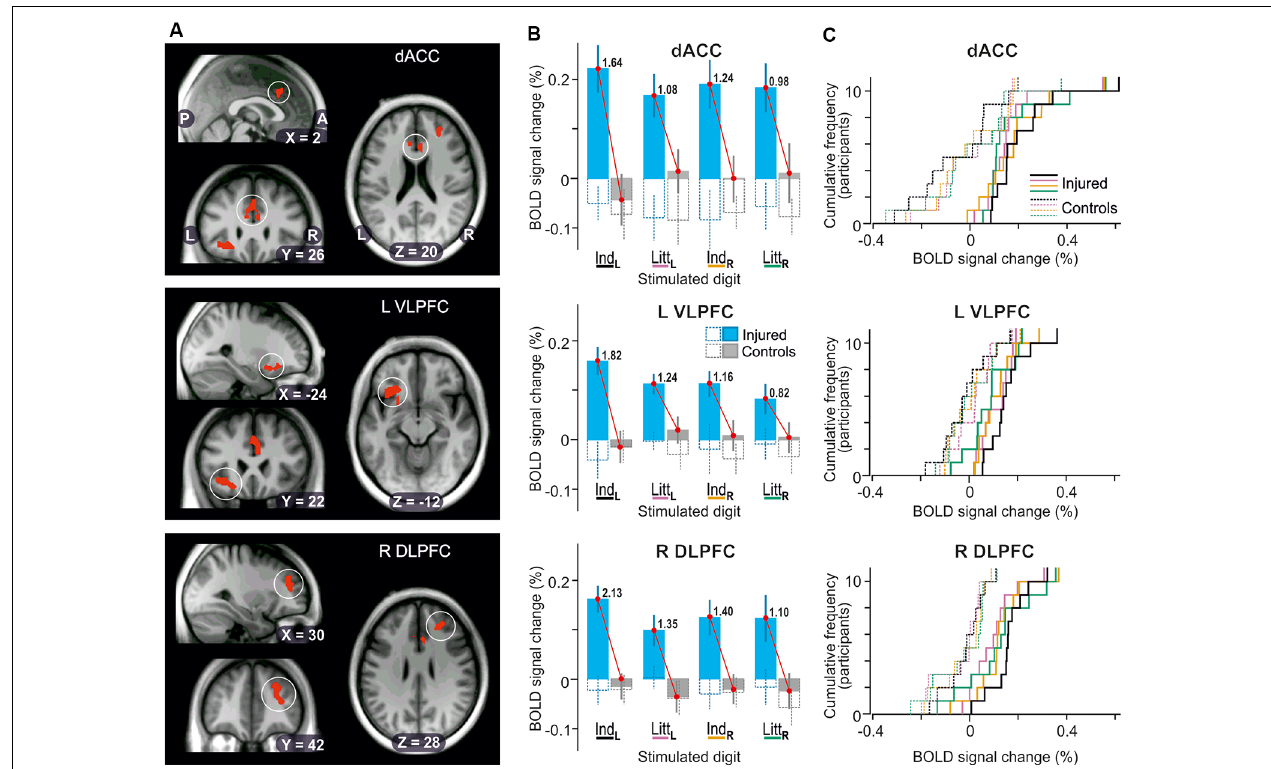
FIGURE 5 | Effect of injury on BOLD responses in the prefrontal cortex. (A) Areas with contiguous voxels (voxel size = 2 × 2 × 2 mm 3 ) showing the main effect of injury detected during stimulation of the left index finger projected on slices of the participant-specific brain image. Top: encircled zones indicate area (218 voxels) with two local maxima in dorsal anterior cingulate cortex (dACC; x , y , z = 6, 22 26, Ze = 3.3; − 6, 28, 22, Ze = 3.1; BA 24). Middle: Area (273 voxels) with two local maxima in left ventrolateral prefrontal cortex and insula (L VLPFC; x , y , z = − 24, 26, − 14, Ze = 3.4; − 36, 22, − 10, Ze = 3.4, BA 47). Bottom: Area (244 voxels) with two local maxima in right dorsolateral prefrontal cortex (R DLPFC; x, y, z = 26, 38, 28, Ze = 3.5; 32, 42, 14, Ze = 3.2, BA 46). P, posterior; A, anterior; L, left; R, right. (B) Columns show BOLD-signal responses to stimulation of each of the four fingers tested based on β -values averaged over all voxels of the areas indicated in panel (A) . For further format details, see Figure 4A . (C) Distribution of BOLD-signal changes across nerve-injured (solid lines) and control participants (dashed lines) during the tactile tasks based on the same data and following the same color code for stimulated finger as indicated in panel (B)